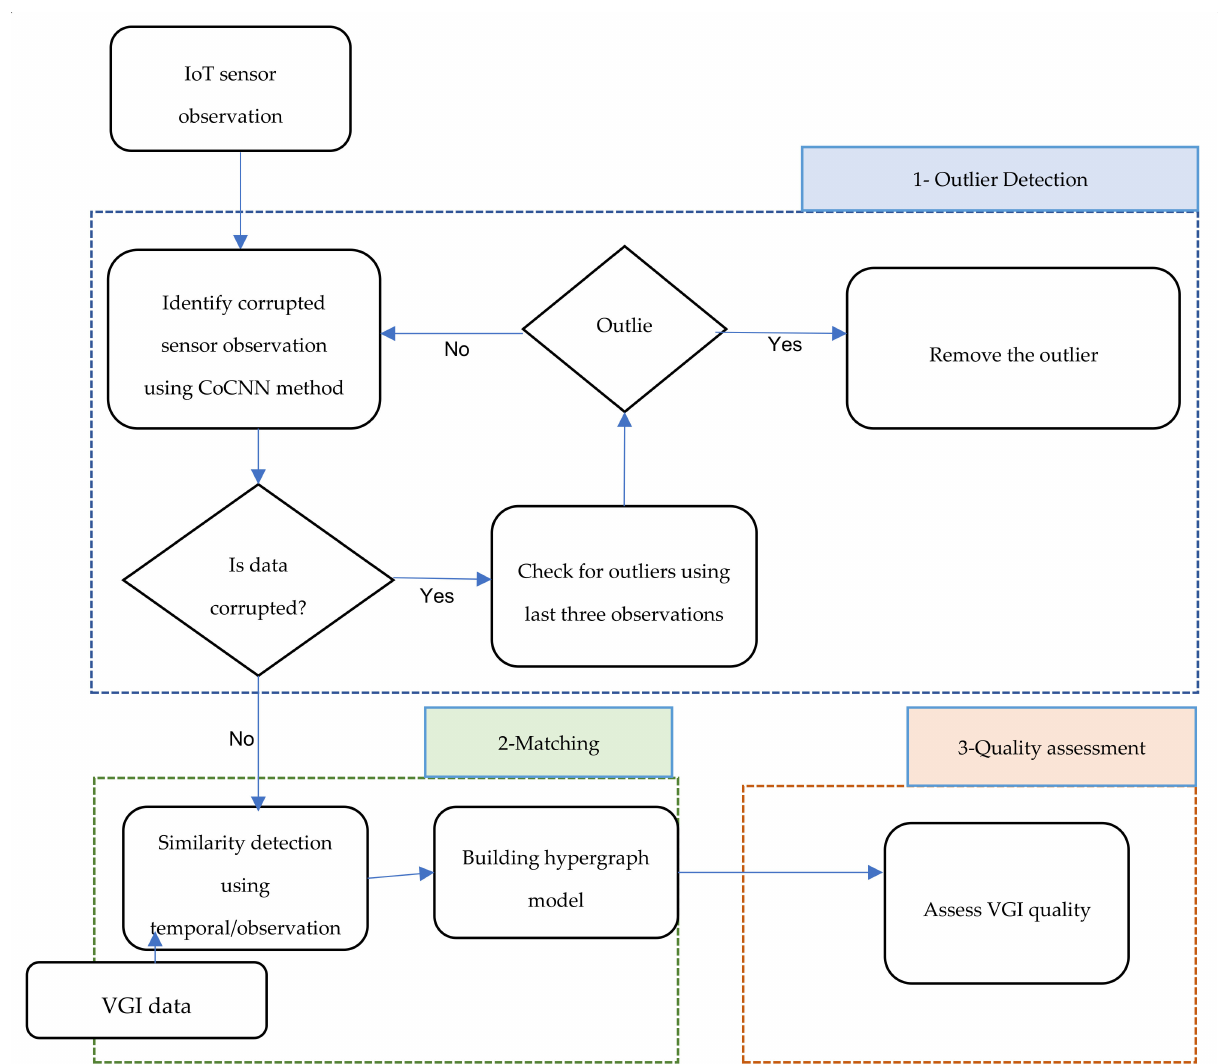
Figure 1. The proposed quality assessment